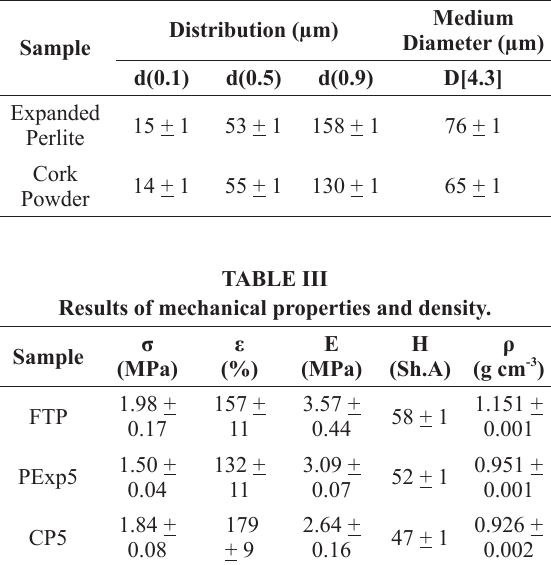
Granulometric distribution of PExp and CP.